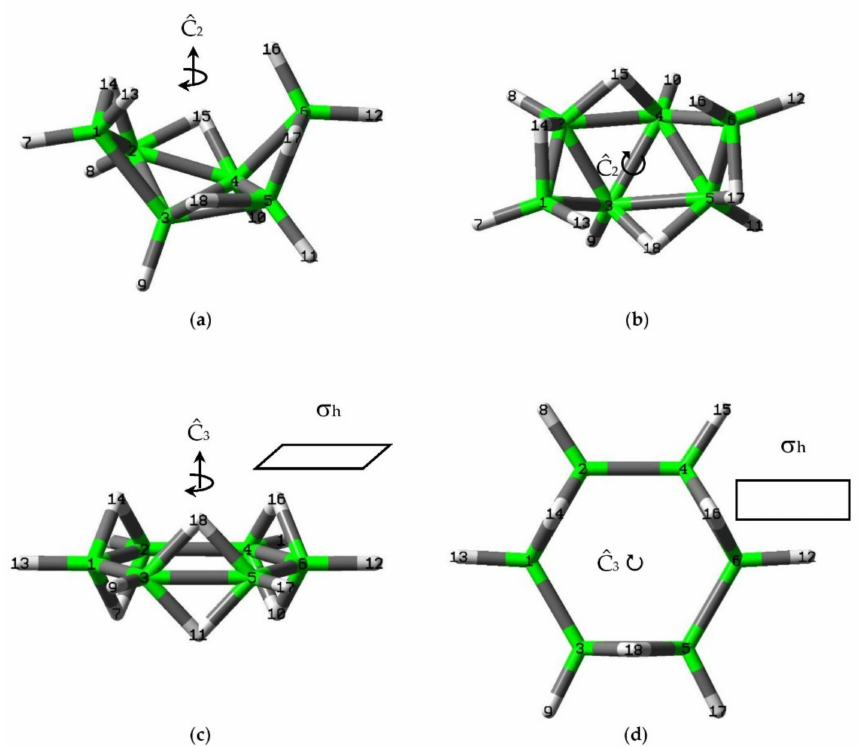
Figure 1. Two projections of known 3D hexaborane(12) with C 2 symmetry ( a ) perpendicular to the ˆC 2 rotation axis and ( b ) along the ˆC 2 rotation axis, and two projections of unknown planar 2D hexaborane(12) with D 3h symmetry ( c ) perpendicular to the ˆC 3 rotation axis and σ h plane and ( d ) along the ˆC 3 rotation axis and on the σ h plane. Atom labels are shown for boron (green) and hydrogen